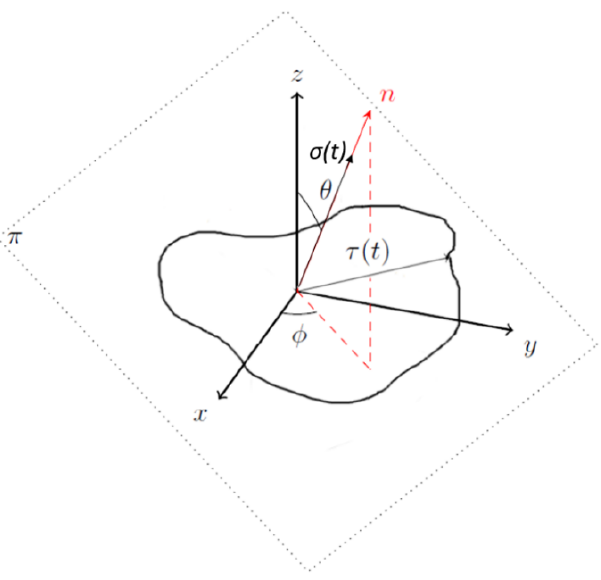
Figure 10. Normal stress and shear stress path in a material plane.